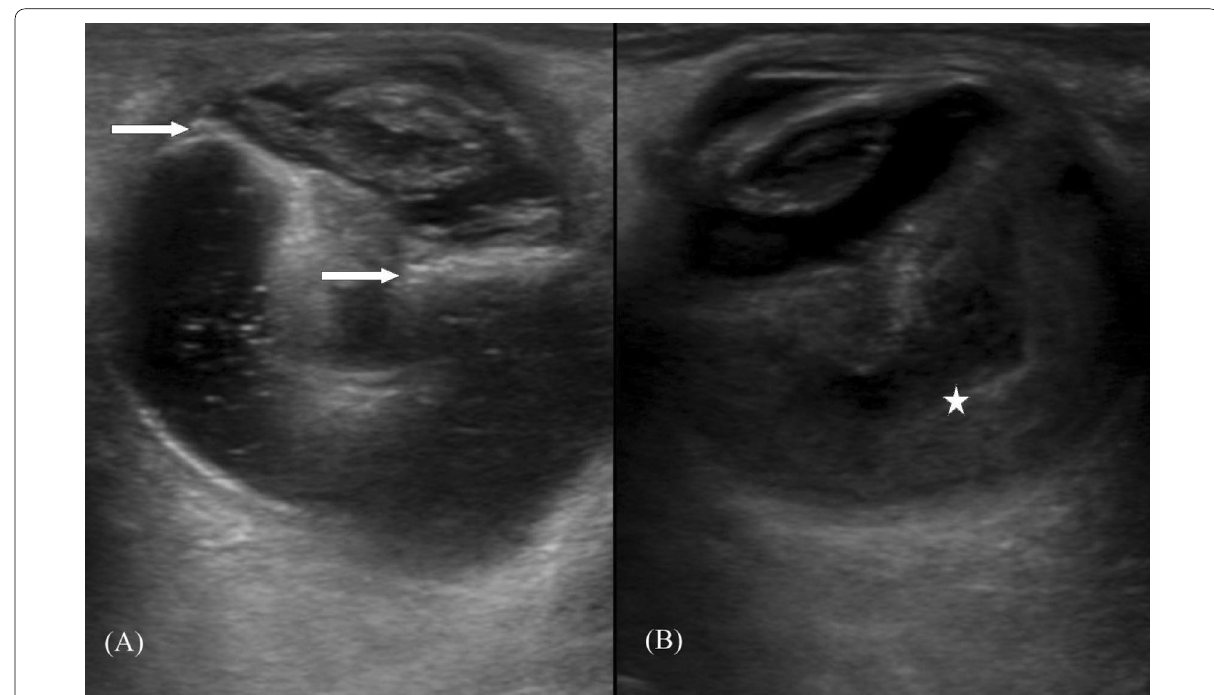
Fig. 6 A Transverse sonogram of the right orbit through the lens shows silicone oil globules as anechoic areas with hyperreflective dots within the globules (due to emulsified silicone droplets), and echogenic arcs (arrows) at the interface of the globules and the vitreous chamber. Lens shows cataractous changes. B Transverse sonogram of the left orbit through the lens shows evidence of chronic total retinal detachment (asterisk) obliterating the vitreous chamber and cataractous changes in the